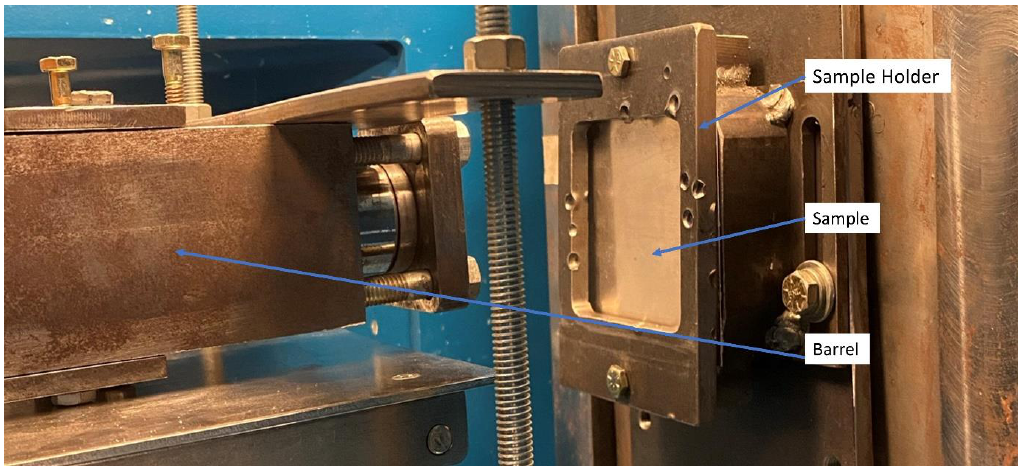
Figure 4. Gas gun apparatus used for performing the high velocity impact testing.